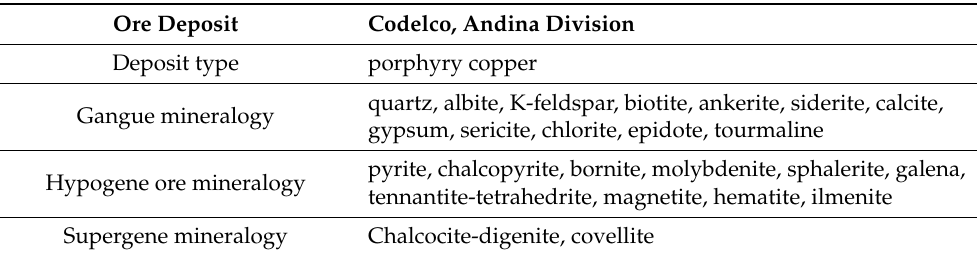
Table 2. Common minerals observed in the Codelco Andina mine.